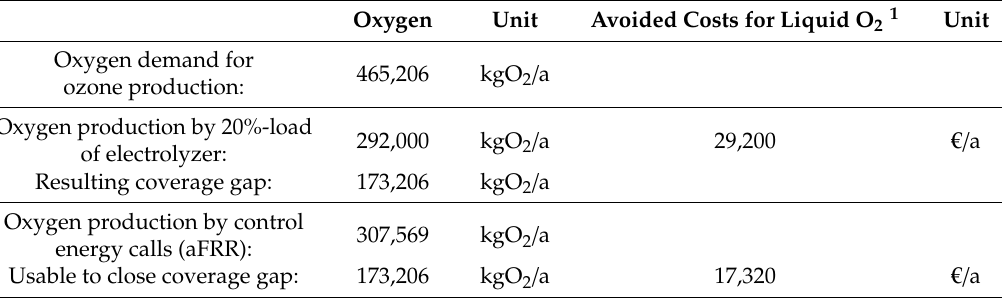
Table 6. Oxygen demand and avoided costs depending on the “source” of